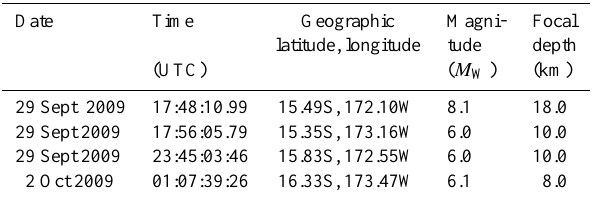
Table 1. Characteristics of the Samoa earthquake and its main aftershocks (reported by http://earthquake.usgs.gov/).